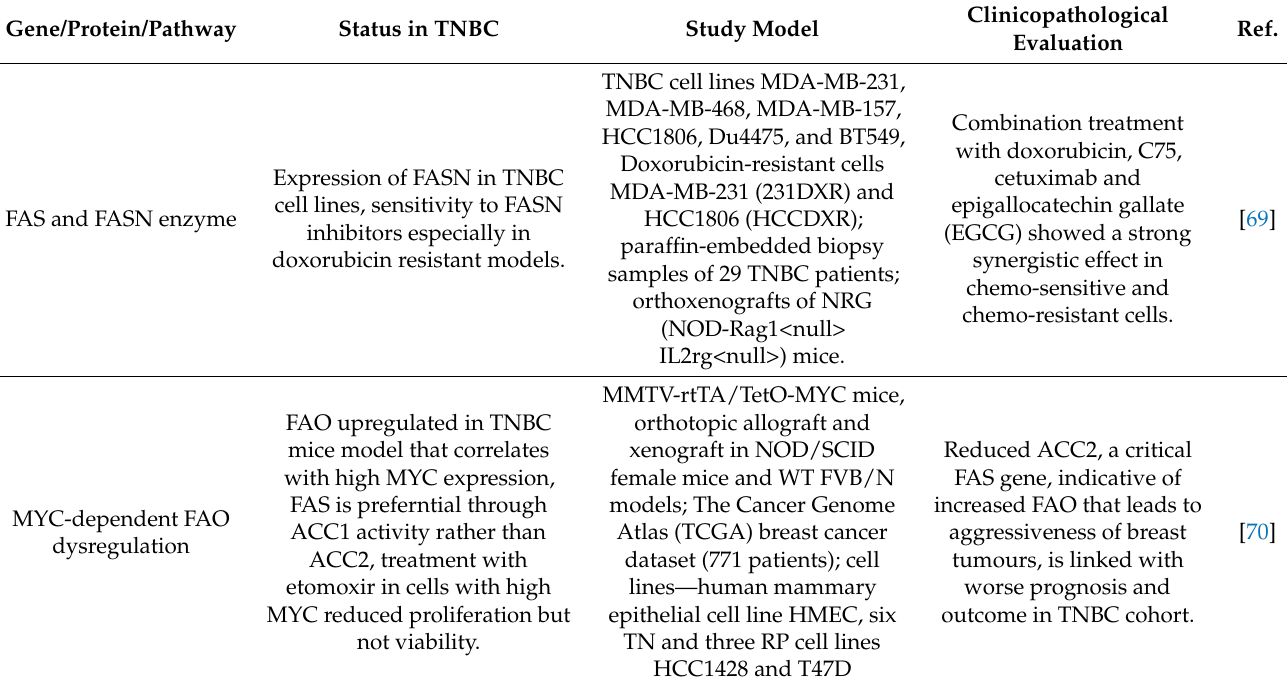
Table 3. Fatty acid metabolism in